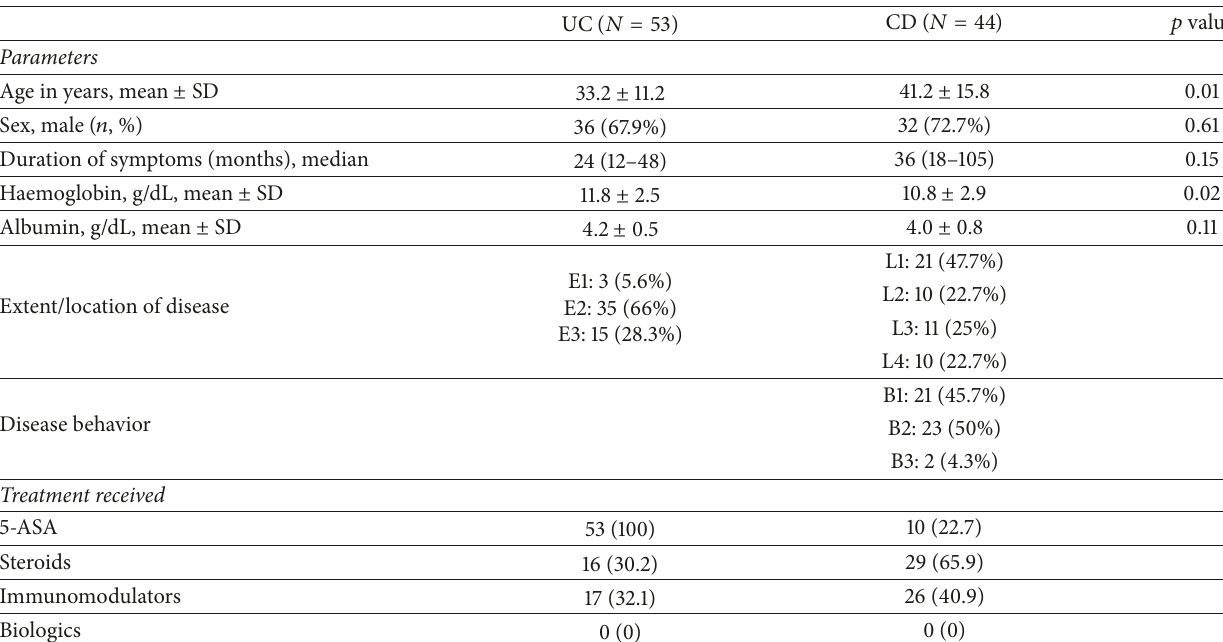
Table 1: Baseline characteristics of patients of ulcerative colitis and Crohn’s disease.